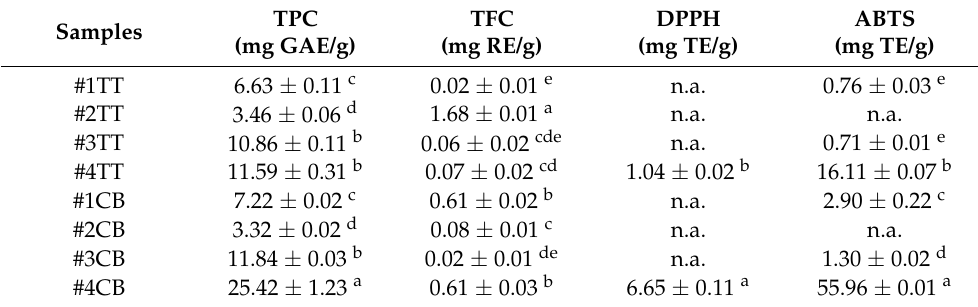
Table 2. Phenolic content of the tested samples.